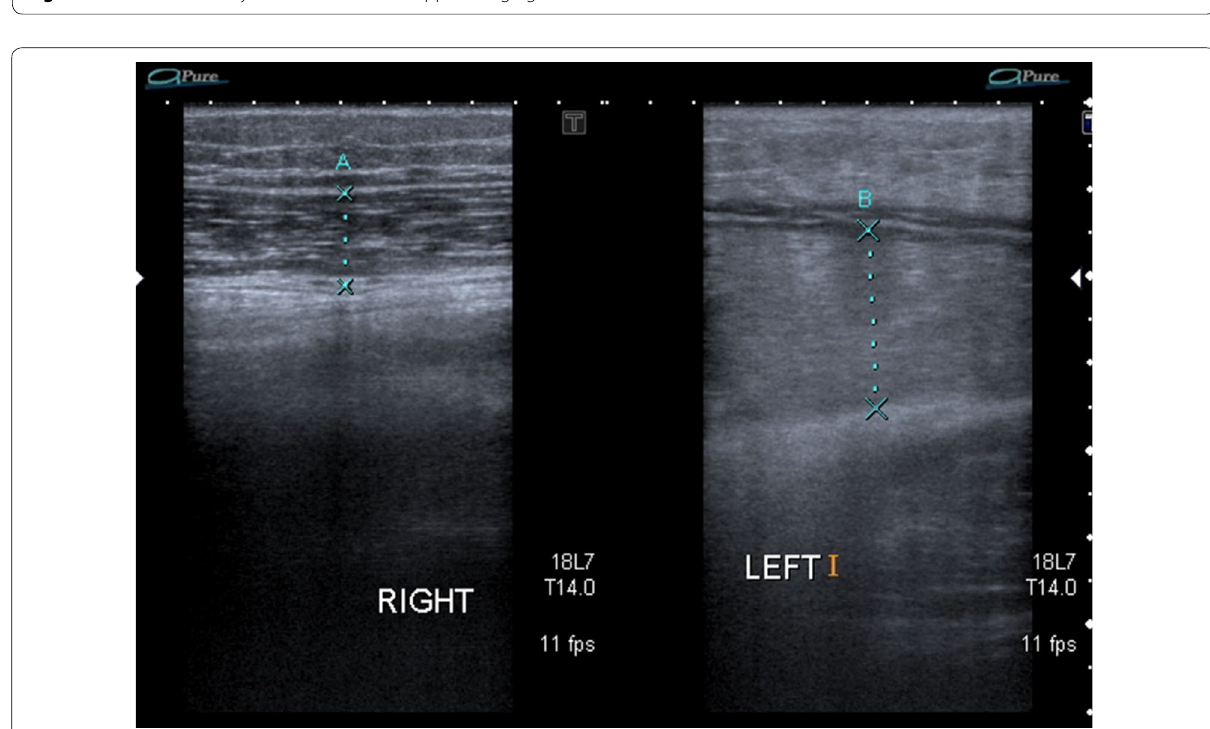
Fig. 7 Comparison to the contralateral right side proves swelling and oedema of the affected